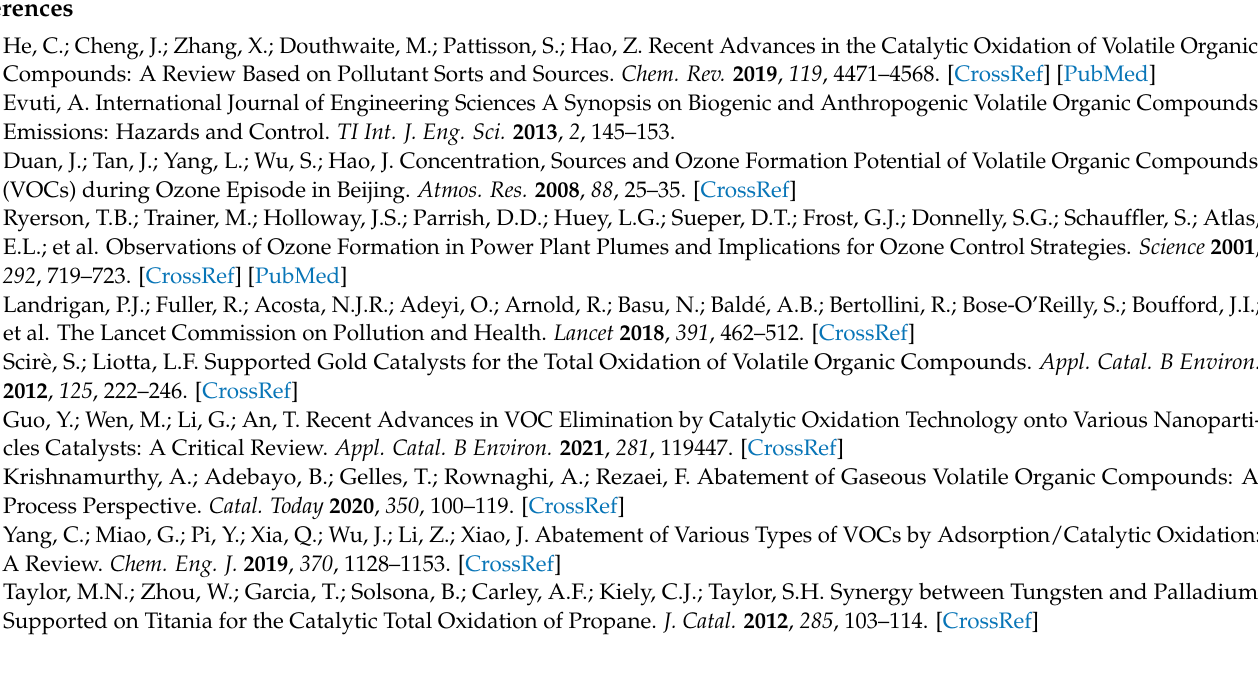
Table S2: XPS derived surface elemental concentrations for ceria-manganese mixed metal oxide catalysts prepared by co-precipitation with sodium carbonate, Table S3: Rate of reaction normalised to surface area for Ce 0.25 Mn 0.75 O x catalyst prepared by different